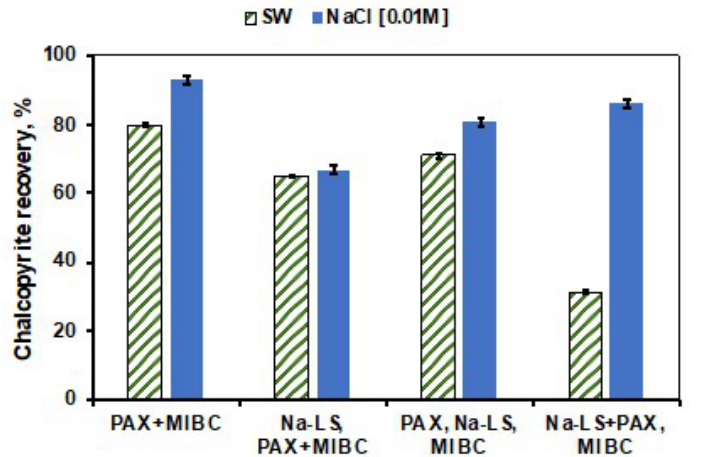
Figure 5. Effect of the order of addition of the reagents on the recovery of chalcopyrite at a concentra- tion of 10 ppm Na-LS, 25 ppm PAX and 15 ppm MIBC at pH 8 in seawater (SW) and 0.01 M NaCl.